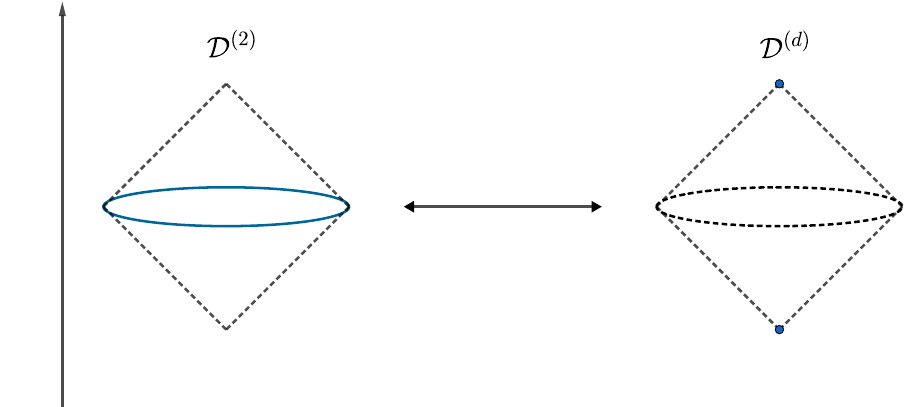
Figure 6 . The duality between a codimension-two defect [Left] and a codimension- d defect [Right]. The codimension- d defect is given by a pair of operators located at the tips of the causal diamond of the dual